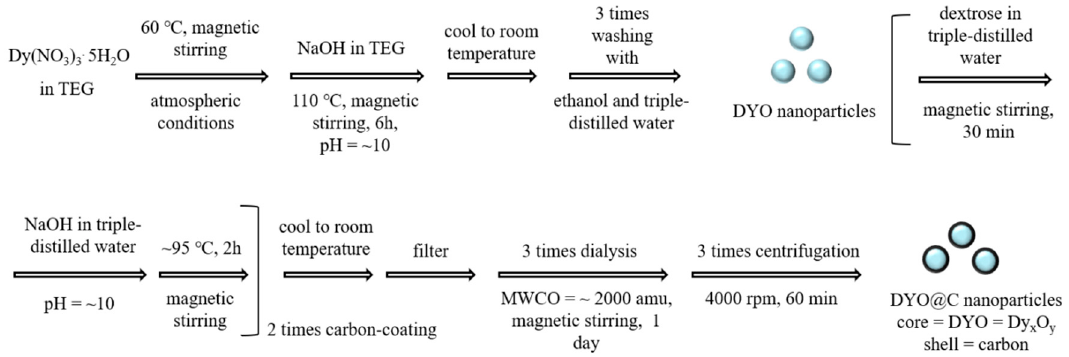
Figure 10. Synthesis of DYO@C core–shell nanoparticles (core = DYO = Dy x O y and shell =